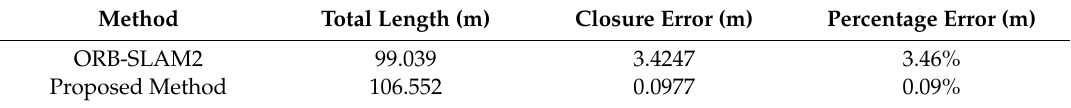
Figure 14. Camera trajectories produced by ORB-SLAM2 and the proposed method are shown in white and red, respectively. Table 5. Camera trajectory error results for ORB-SLAM2 and the proposed method.